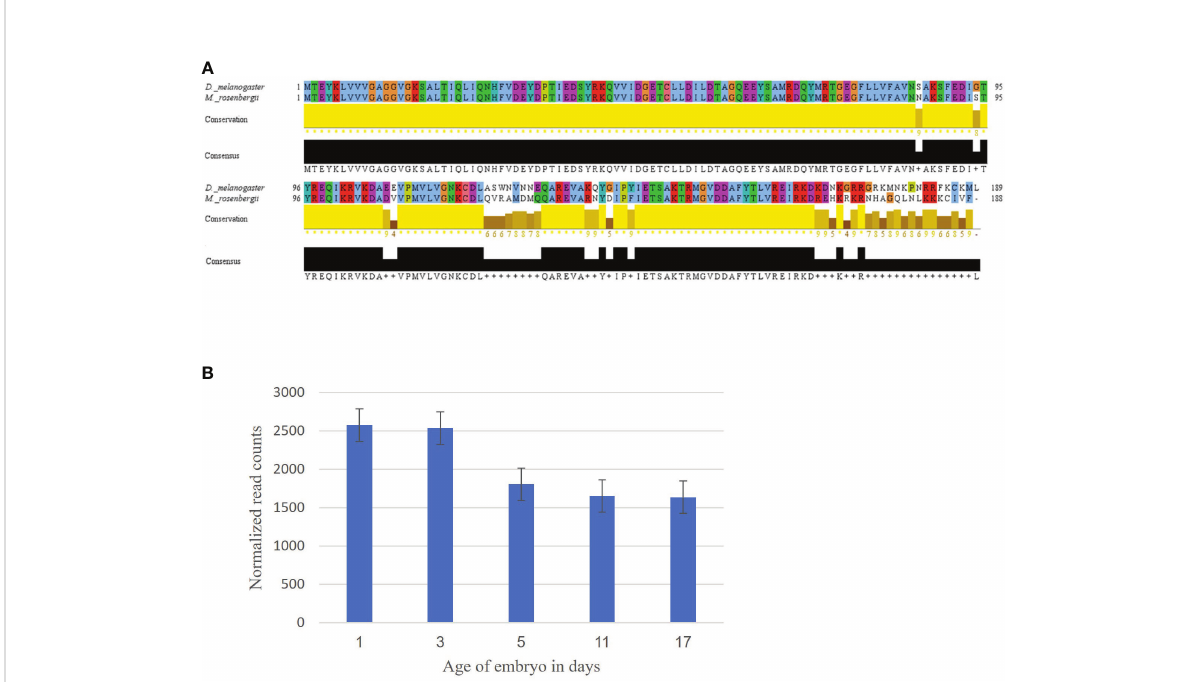
FIGURE 1 Mining of the Ras gene in M. rosenbergii . ( A ) Alignment of the Ras amino acid sequence from D. melanogaster with a putative M. rosenbergii Ras based on transcriptomic libraries. High conservation of the protein sequence alignment was found using Jalview (with default settings). For each position in the sequence alignment, the conservation rate and the consensus sequence are shown below. ( B ) MrRas expression pattern in embryos of different ages. The x-axis represents embryo development days, and the y-axis, normalized read counts. The error bars represent standard